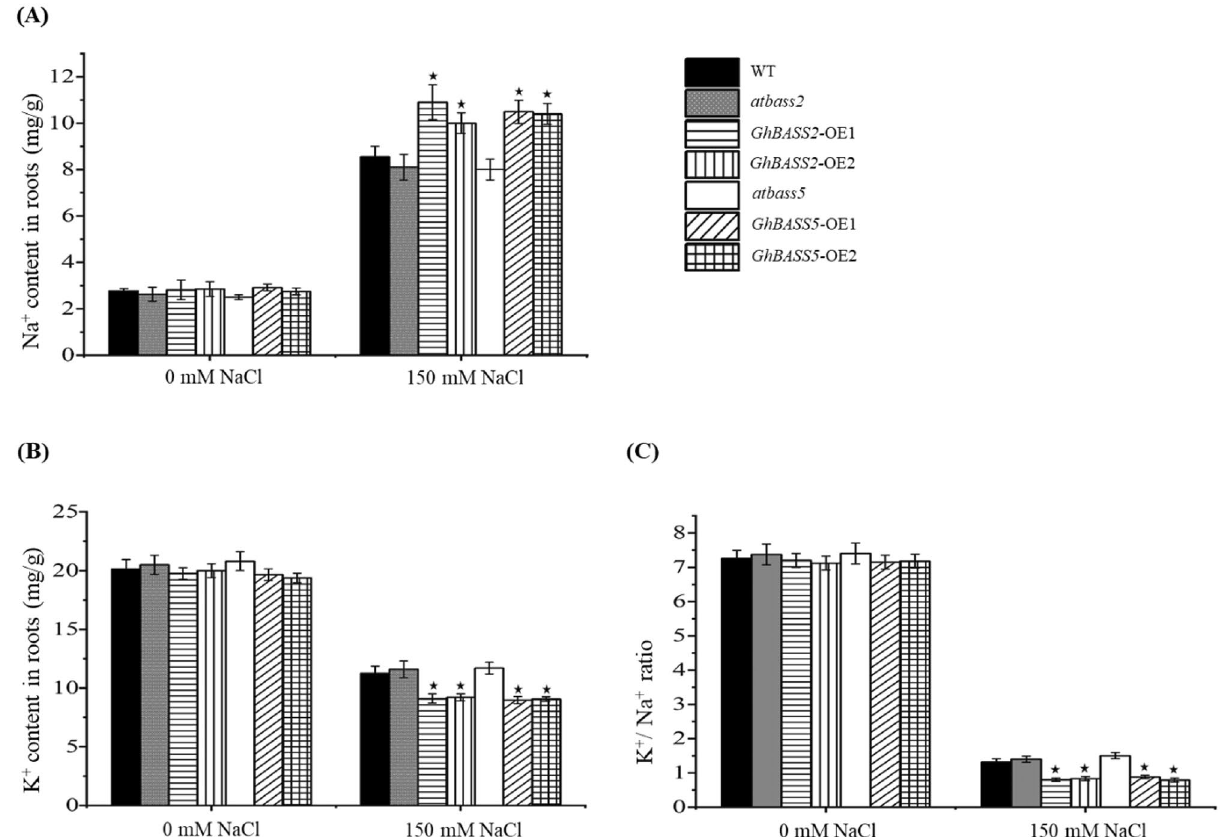
Figure 12. Ion contents in GhBASS2 - and GhBASS5 -overexpressed plants with the absence or presence of 150 mM NaCl for 7 days. ( A ) Na + content in the roots of OE lines, mutants and WT plants. ( B ) K + content in the roots of OE lines, mutants and WT plants. ( C ) K + /Na + ratio. The ionic concentration is presented as mg/g dry weight. Means and standard deviations were based on three independent biological replicates. Error bars represent the variation among three independent biological replications. Asterisks indicate the significant difference ( * , P = 0.05) from WT by Tukey’s HSD